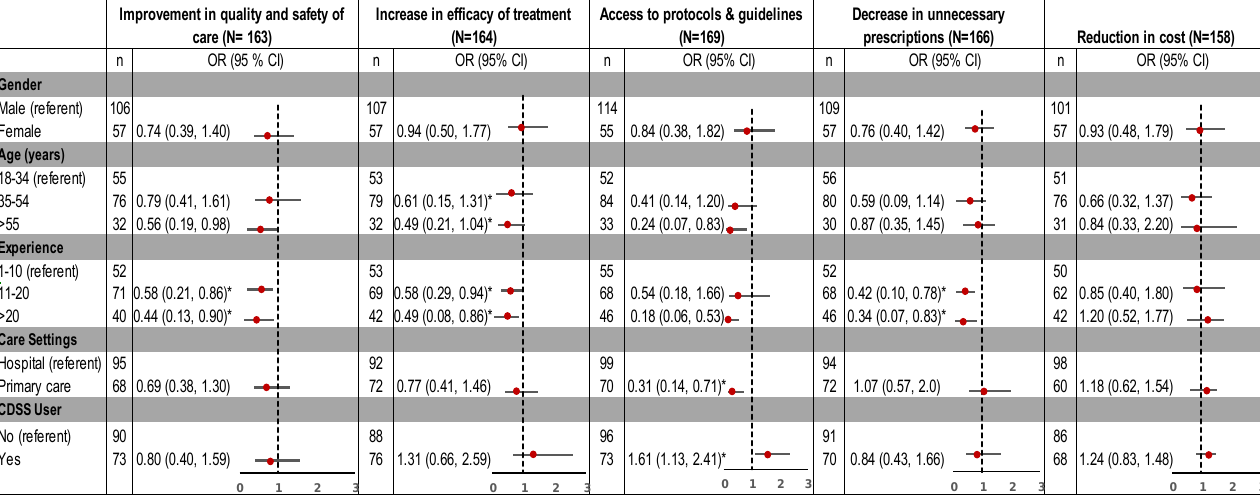
Figure 3. Association of perceived benefits to implementation of CDSS, by demographic characteristics. OR: odds ratio; CI: confidence interval. * Significant predictors, as confidence interval does not include 1.0.